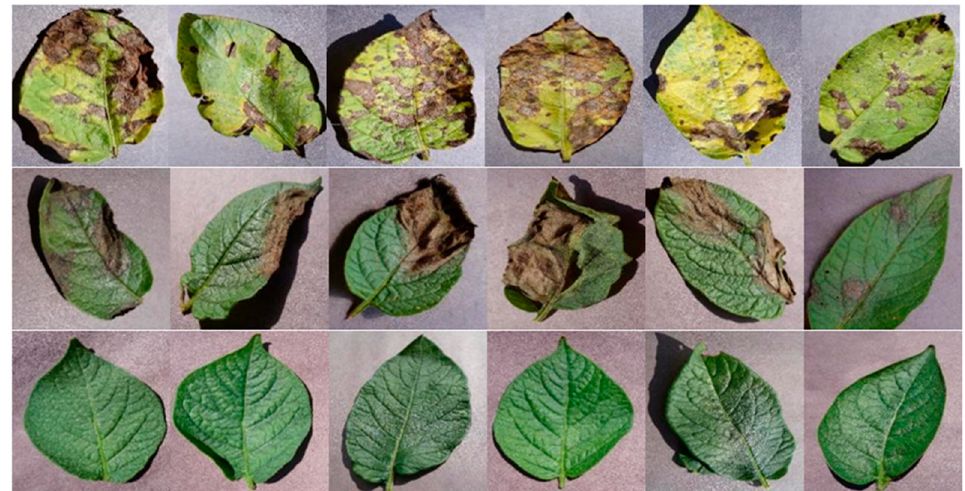
Figure 1. Example of potato leaf diseases. Three types of potato leaves including early blight, late blight, and healthy.